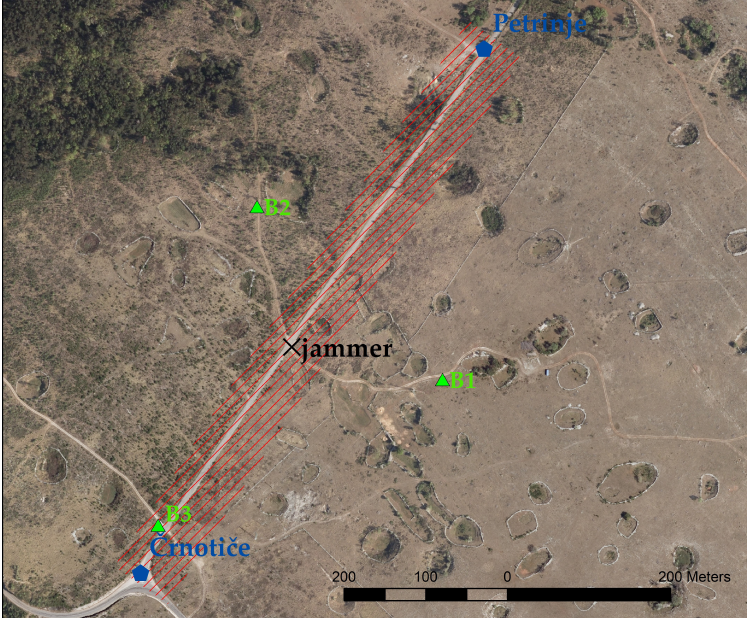
Figure 5. Positions of the base receivers (B1–B3), jammer and directions of movement of the vehicle (towards Petrinje and ˇCrnotiˇce and vice versa) (own